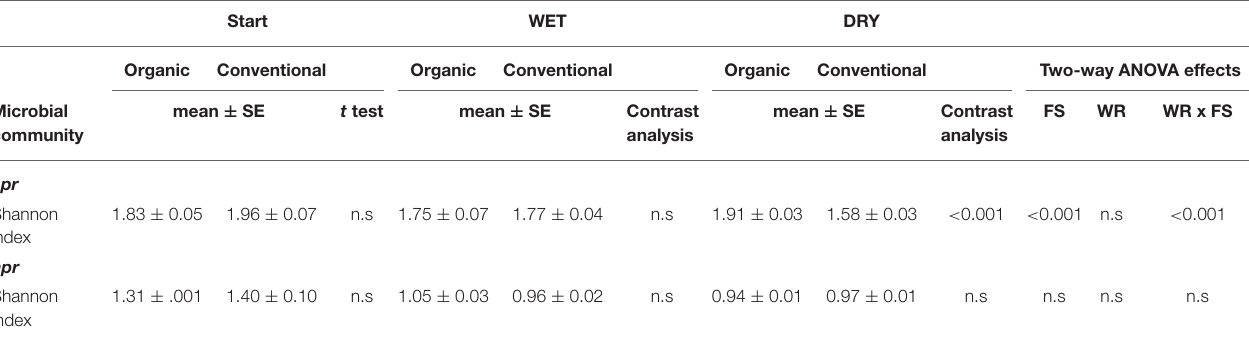
TABLE 4 | Diversity of alkaline metallopeptidase ( apr ) and neutral metallopeptidase ( npr ) encoding microbial communities based on Shannon index. Start WET DRY Organic Conventional Organic Conventional Organic Conventional Two-way ANOVA effects Microbial mean ± SE t test mean ± SE Contrast mean ± SE Contrast FS WR WR x FS community analysis analysis